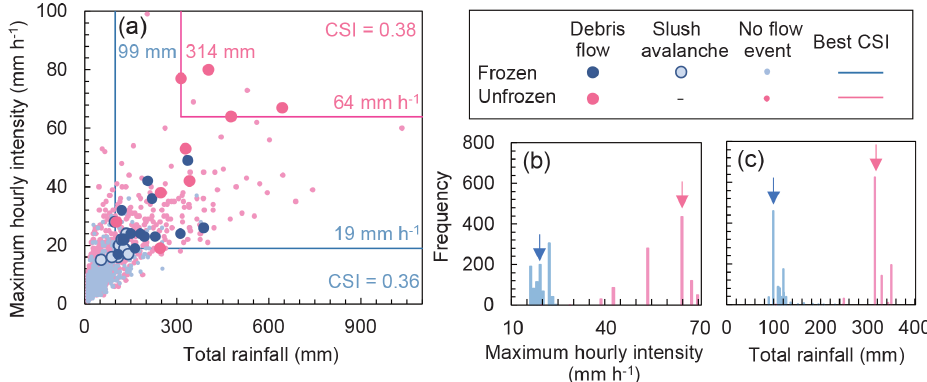
Figure 10. Thresholds of total rainfall and maximum hourly rainfall intensity triggering debris flows and slush avalanches. (a) Comparison of the total rainfall and the maximum hourly intensity of rainfall events with or without debris flows and slush avalanches for rainfall events in the frozen and unfrozen periods. The solid lines in the plots indicate the rainfall thresholds that optimally separated rainfall events that induced debris flows and slush avalanches from those that did not. Frequencies of (b) maximum rainfall intensity and (c) total rainfall that produced the highest critical successful index (CSI) obtained by 1000 bootstrap resamplings. Arrows indicate the values that produced the highest CSI in the analysis using the original dataset (same as values in a ).